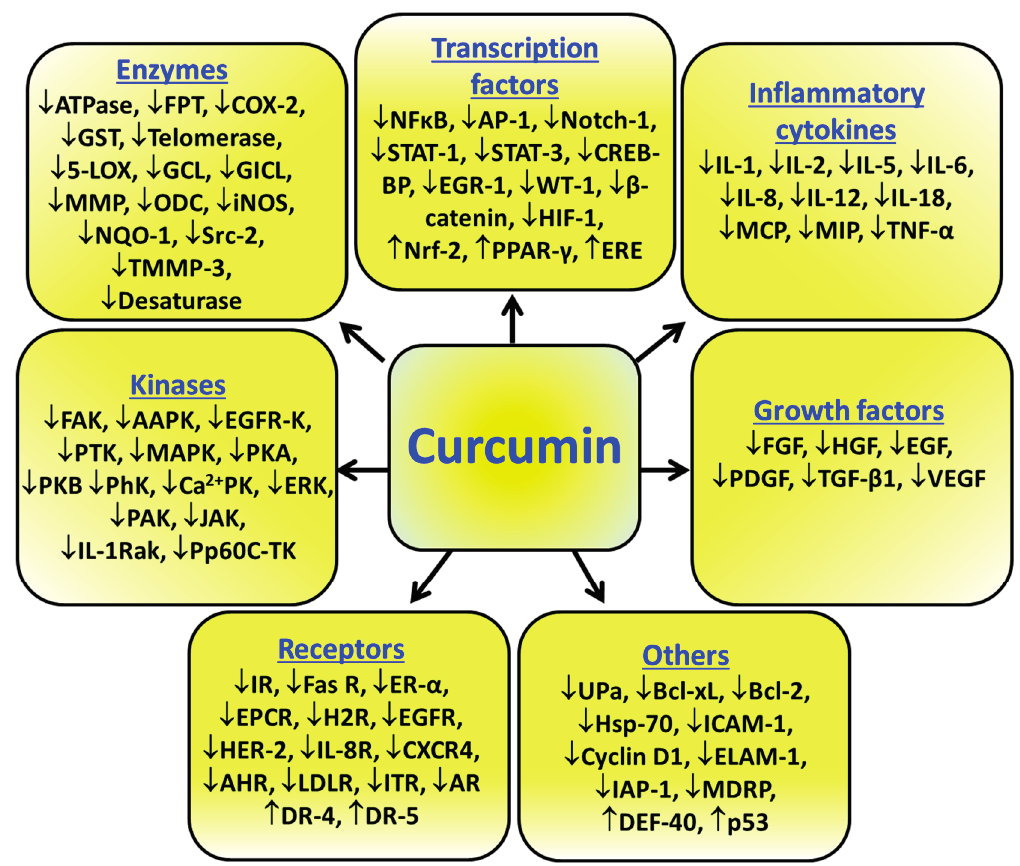
Figure 2. Molecular targets modulated by curcumin. ↓ Down-regulated targets; ↑ Up-regulated